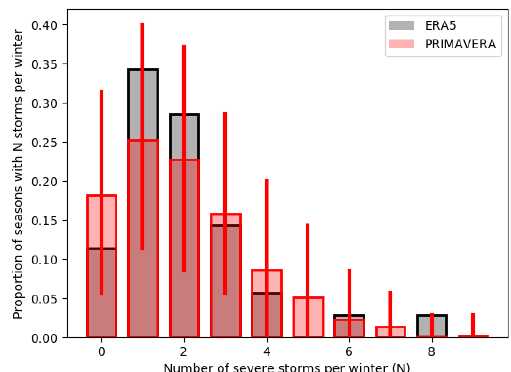
Figure 8. Distribution of number of severe storms per winter in PRIMAVERA models (red) and re-analysis (black). The red lines on each bar show the 95% range of season counts for 1000 35-year re-samples of PRIMAVERA